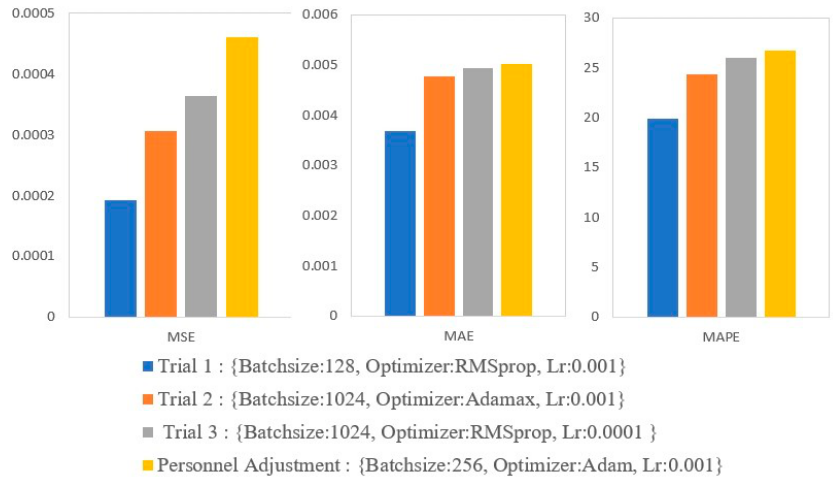
Figure 8. Ranking the top three tuner performance comparisons.